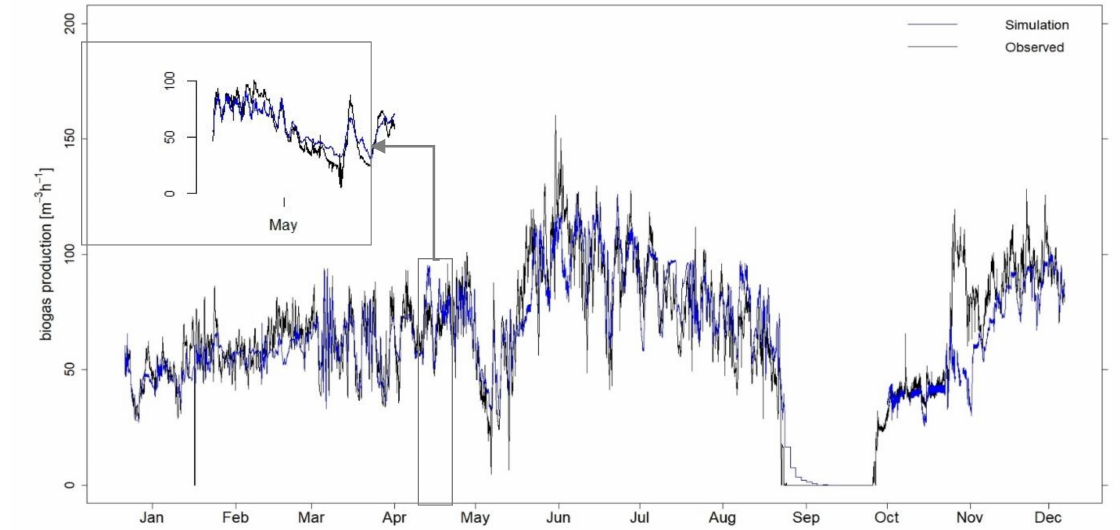
Figure 2. A total of 183 individual simulations, using a training period of 500 observations and 48 lags with a 48 h horizon, of biogas production for digester two, in hourly resolution, with a time window from January to December 2018. The simulated values are shown in blue, while the measured data are overlaid in black for